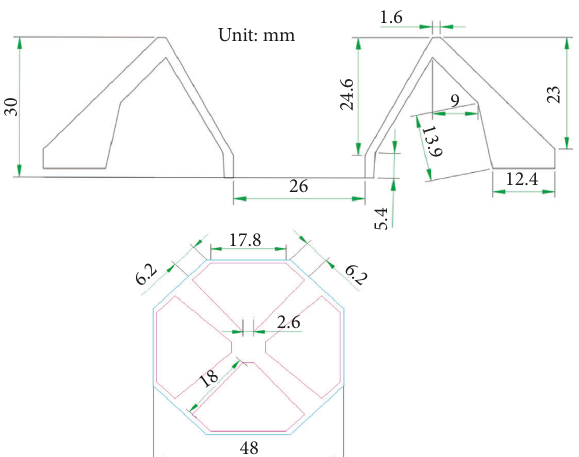
Figure 10: Measured radiation pattern at 1227MHz.